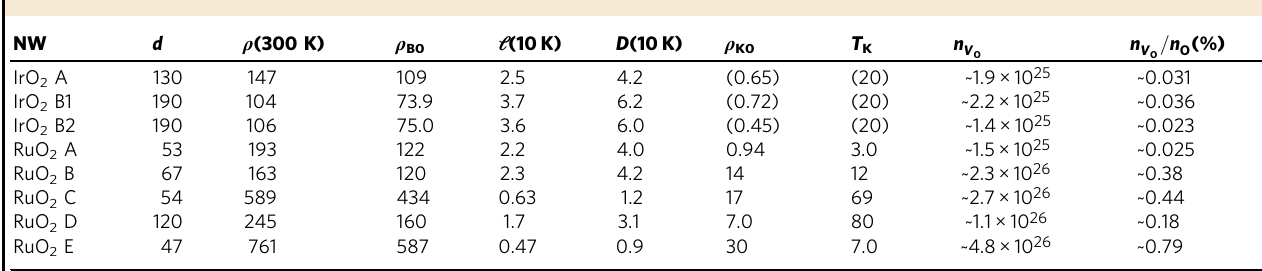
Fig. 1 Atomic arrangement around an oxygen vacancy in M O 2 rutile structure. a Schematics for M O 2 in the rutile structure. The olive and red spheres represent transition-metal ions M 4 + and oxygen ions O 2 − , respectively. V O1 represents an oxygen vacancy. b The metal ions M 1, M 2, and M 3 surrounding V M 2, labeled O4, O9, O10, and O8, form an almost perfect planar square (while O1 0 , O5 0 , O1 form an isosceles triangle. c The four oxygen ions surrounding O3 0 , and O4 0 only form a rectangle, cf. Supplementary Note 4 for details). d The d xz and d yz orbitals at M 2 next to V O1 , with ^ z perpendicular to the O4, O8, O10, and O9 plane, remain essentially degenerate as a result of mirror and C 4 rotation symmetry around M 2. (Due to the non-symmorphic rutile structure, ^ z ∦ ^ z 0 , where ^ z 0 is parallel to the C M 1.). 4 axis at Table 1 Relevant parameters for M O 2